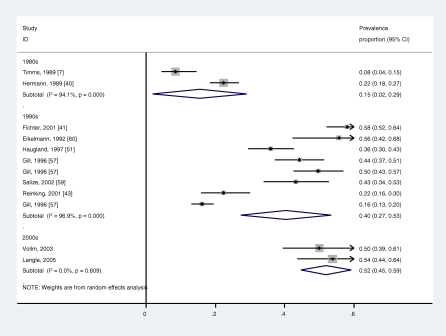
Prevalence of Alcohol Dependence in Homeless Persons by Decade